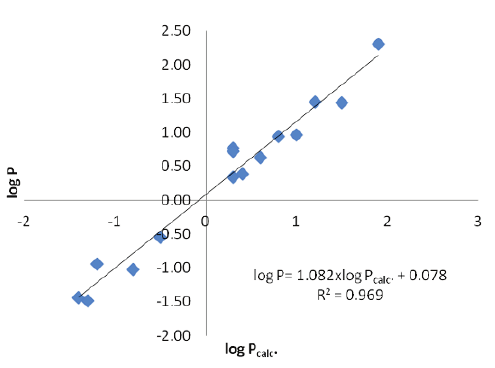
. by similarity calc